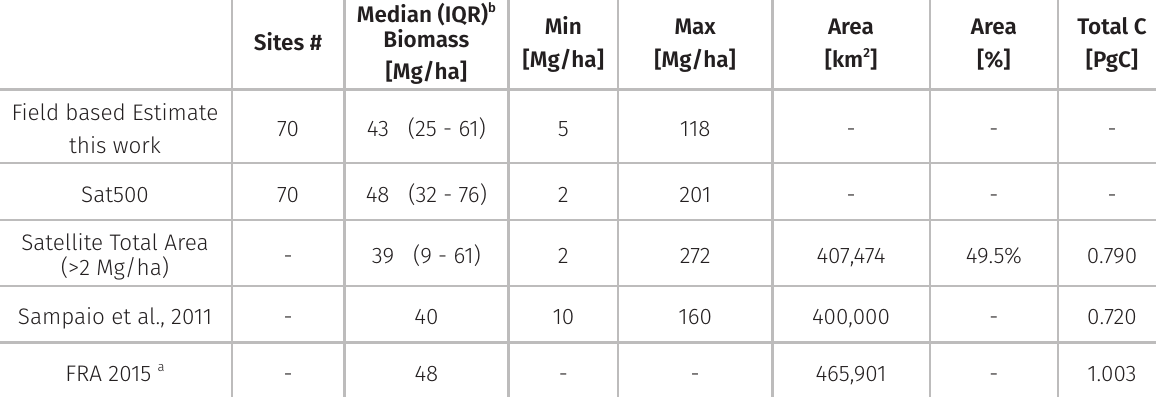
a Data from the Forest Resource Assessment (FRA 2015) for Caatinga biome, based on the forested areas and other wooded lands in year 2000 (carbon estimated considering the 0.45 factor). b IQR refers to the interquartile of the distribution where the numbers in parenthesis correspond respectively to 25% quartile, and 75%